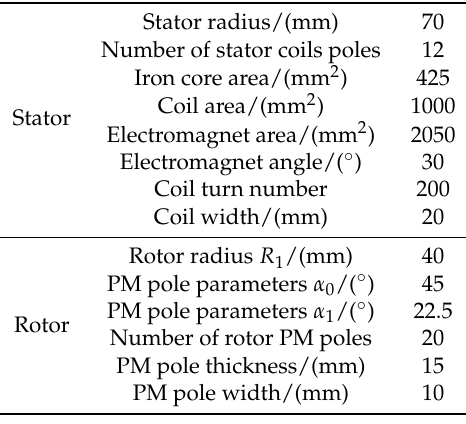
Table 2. Key parameters of the prototype.